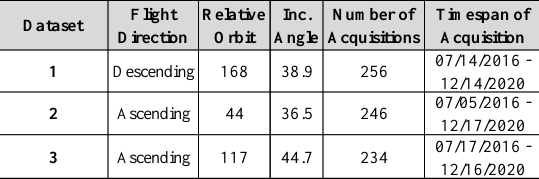
Table 2: Overview of the Sentinel-1 acquisition parameters. D a t a s e